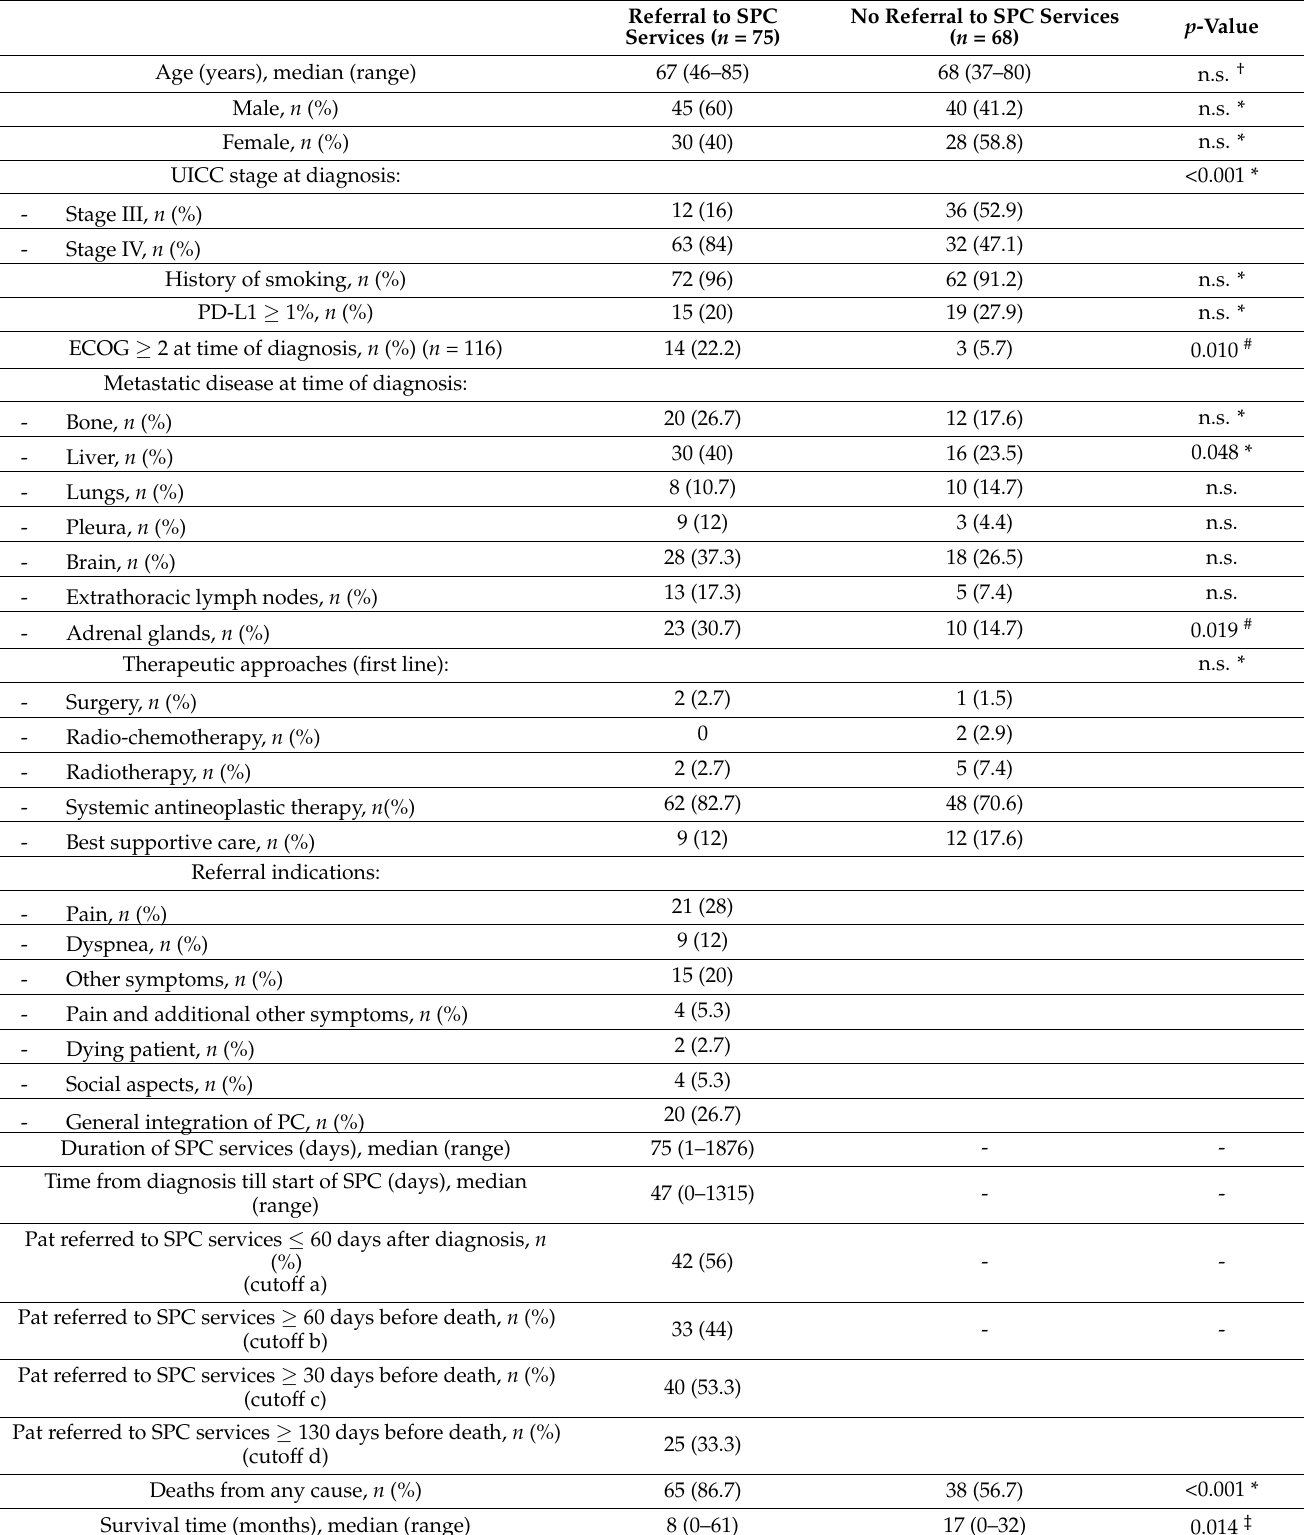
Table 2. Comparison of stage III/IV SCLC patients ( n = 143) with and without